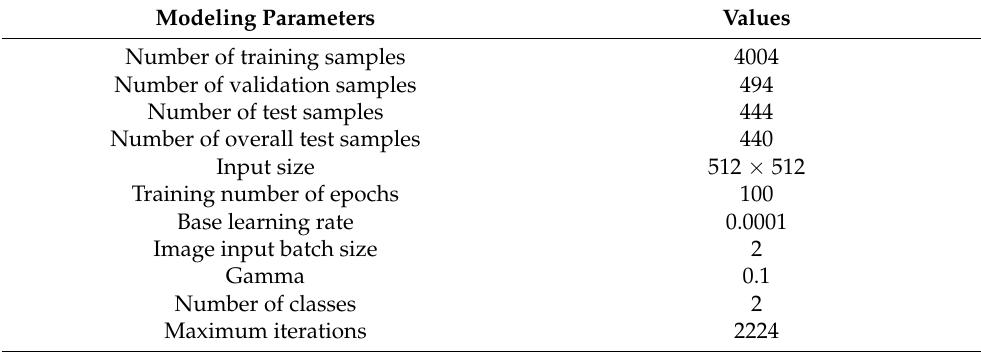
Table 1. Settings of modeling parameters for identifications of leaves and disease